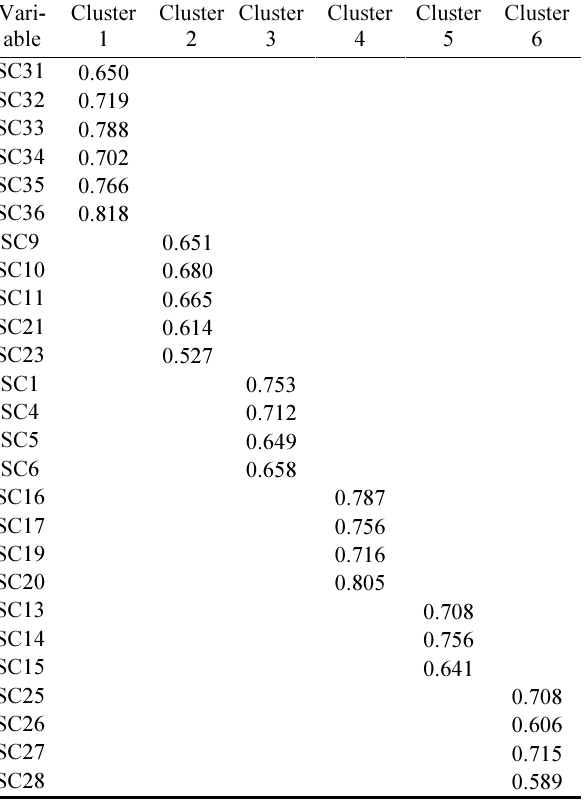
Table 6. Variables of SEM analysis Observed